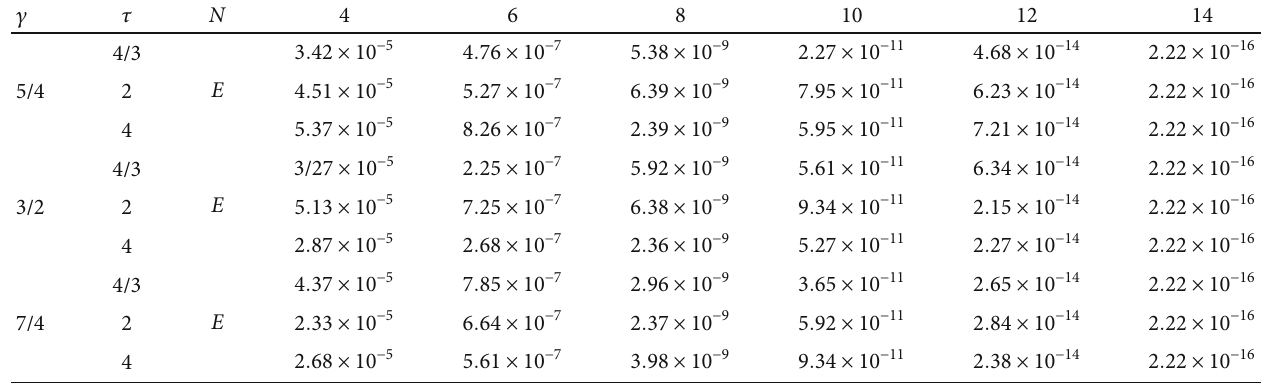
Table 3: Maximum point-wise error of example 3.